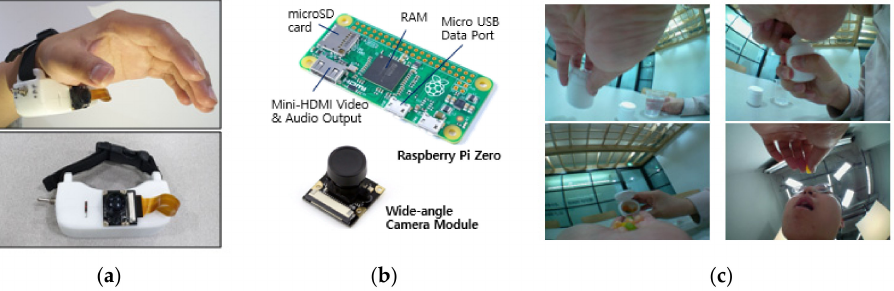
Figure 3. ( a ) Wearable device for monitoring medication behavior with a camera module applied. ( b ) Configuration of the internal module of the wearable device. ( c ) Example of medication behavior data taken from the wearable device